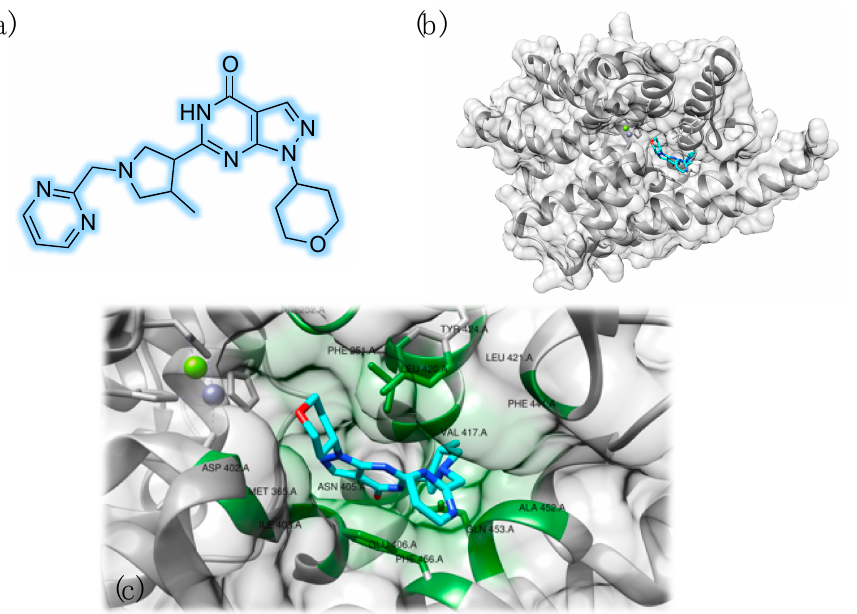
Figure 3. Chemical structure of the PDE9 inhibitor PF-04447943 ( a ). Three-dimensional structure of the complex with PDE9 (PDB ID: 4E90) ( b ). Detailed view of the interaction pattern of PF-04447943 with PDE9: zinc is represented in purple and magnesium is reported in green. Interacting residues have been labeled and highlighted in green ( c ).